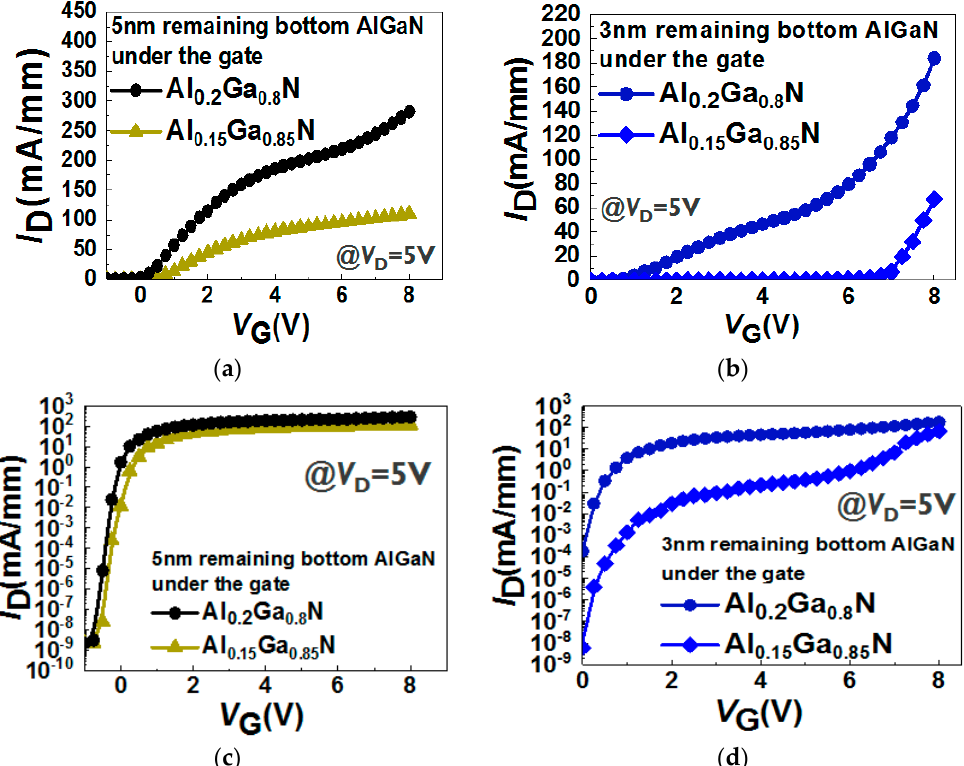
Figure 9. I D - V G in a linear scale ( a , b ) and a logarithmic scale ( c , d ) in the devices with 5 nm or 3 nm remaining bottom AlGaN layer under the gate region with different Al% in the bottom AlGaN barrier.